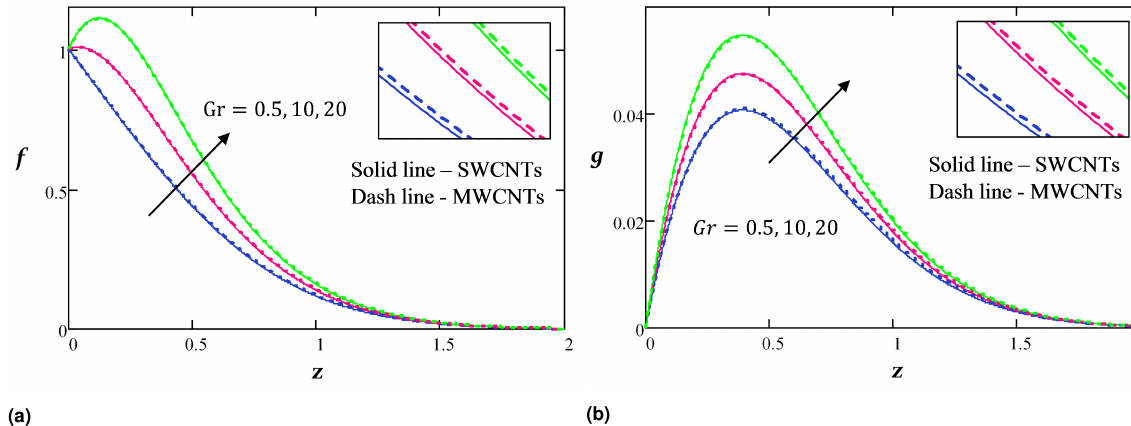
Fig. 5. f and g profiles under the impact of different Gr values.